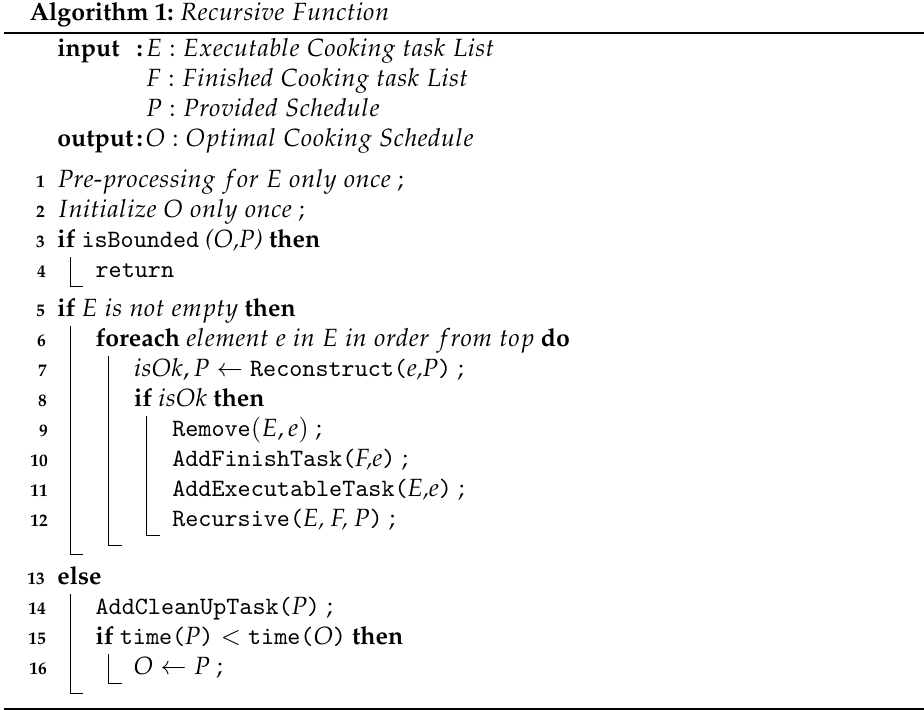
Algorithm 1: Recursive Function